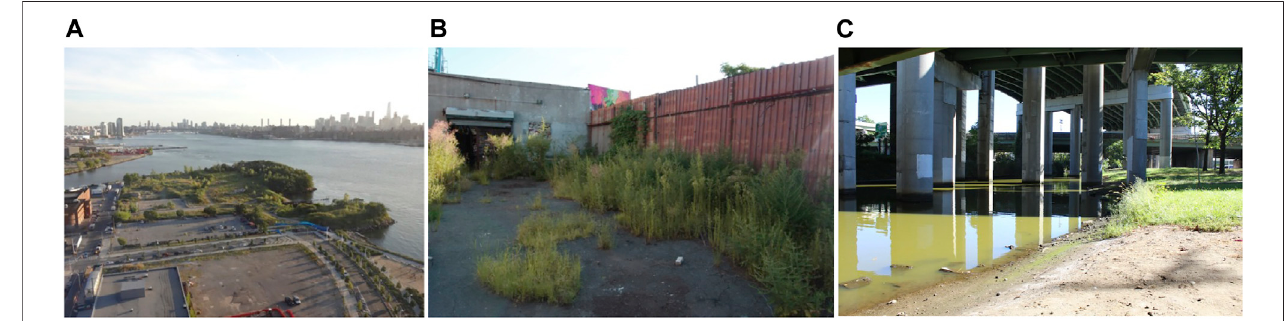
FIGURE2| ThreeruderallandscapesinNewYorkCity. (A) ApostindustrialforestonneglectedlandinHuntersPointSouth,Queens,NewYork,2015; (B) Aformer autorepairshopinCrownHeights,Brooklyn,NewYork,2017; (C) AruderalsiteunderneaththeVanWyckExpresswayinCoronaFlushingMeadowsPark,Queens,New York, 2018. Photos by Christopher